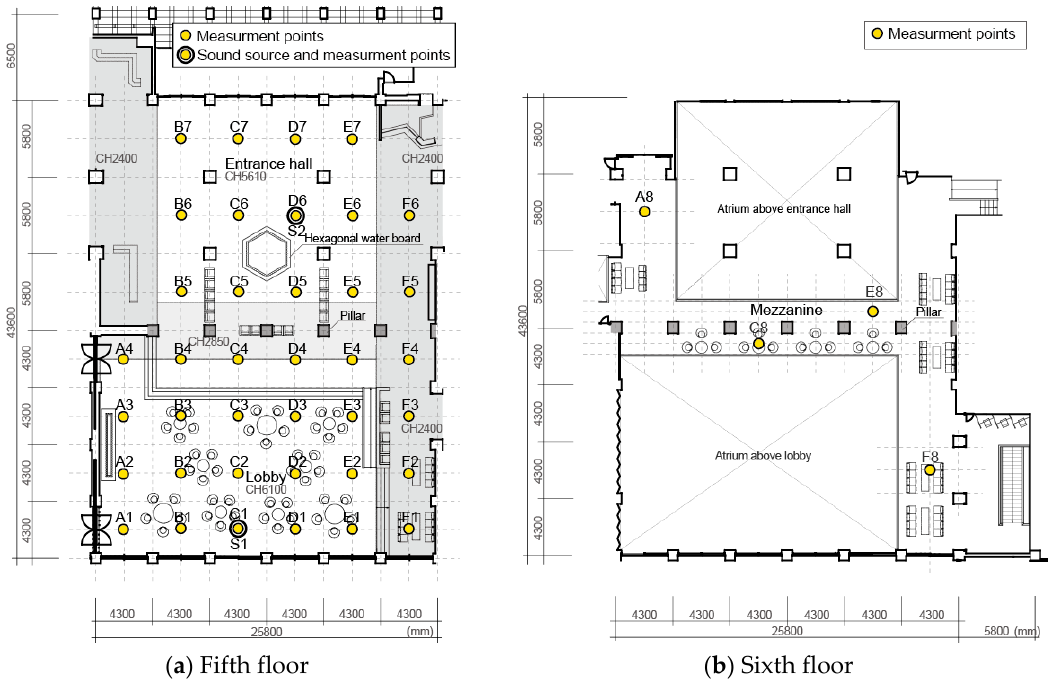
Figure 3. Sound sources and measurement points on the ( a ) fifth floor and ( b ) sixth floor of the measurement items of No.2 to No. 5 in Table 1.